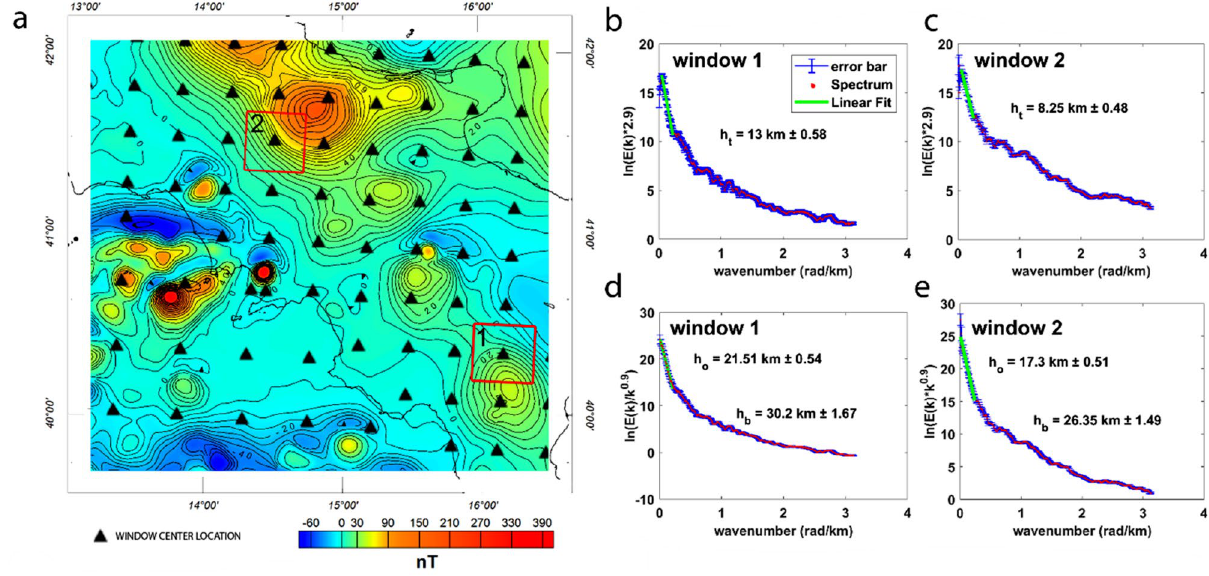
Figure 3. ( a ) Map of the aeromagnetic field in the Southern Italian region. Black triangles indicate the windows center used for the spectral analysis. We show examples of radially averaged power spectra of the magnetic field for estimating the depth to the top ( b , c ) after correcting the power spectra by k −2.9 and the radially averaged wavenumber-scaled power spectra for estimating the depth to the centroid ( d , e ) after correcting the power spectra by k −2.9 . The location of windows is indicated by red squares (windows 1 and 2). h t is the depth to the top, h o the depth to the centroid and h b the depth to the bottom, with their respective